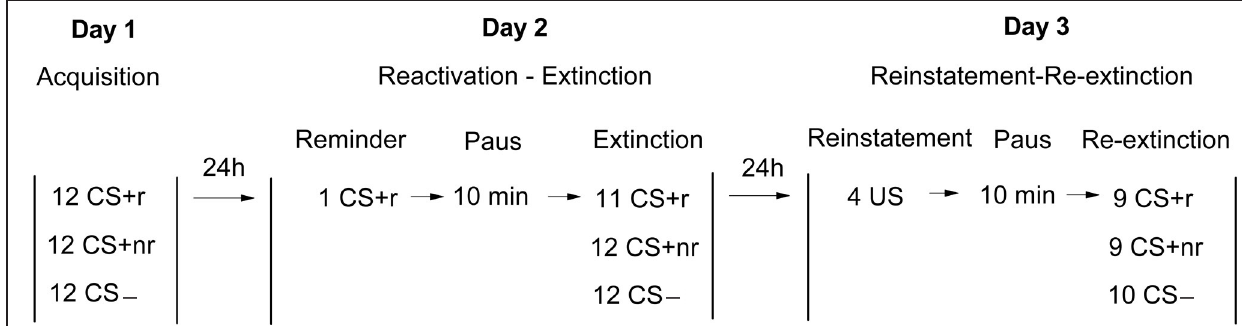
(Reactivation). This was followed by a 10min pause after which subjects were exposed to repeated non-reinforced presentations of each CS (Extinction). On day 3, subjects received four unsignaled presentations of the US (Reinstatement). This was followed by a 10min pause after which subjects again were exposed to repeated non-reinforced presentations of each CS